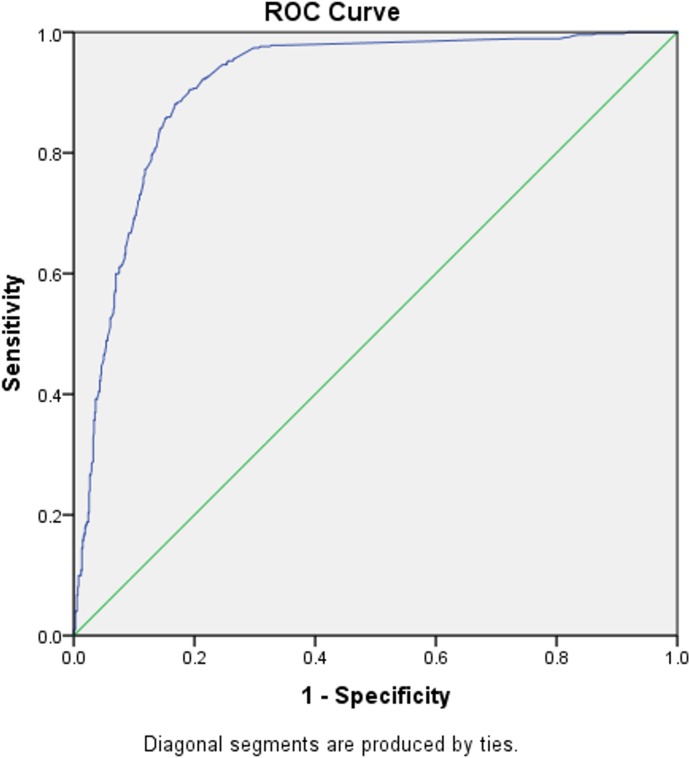
Receiver-operating characteristic (ROC) curve for determining the optimal cutoff of IgG for H. pylori infection compared to histology confirmed by IHC.Sensitivity, specificity, PPV, and NPV were 81.0%, 86.3%, 87.9%, and 78.6%, respectively.